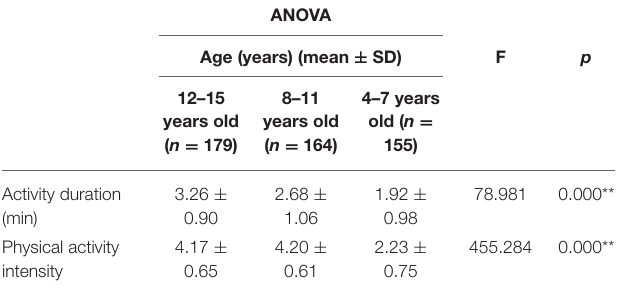
TABLE 3 | Analysis of variance between the duration of children’s physical activity and children’s age.